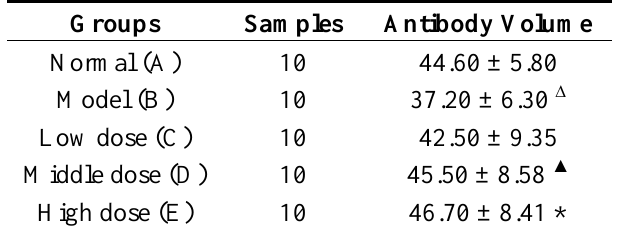
Table 7. Effect of Fuzhuan brick-tea extract on serum hemolysin in mice ( x ±